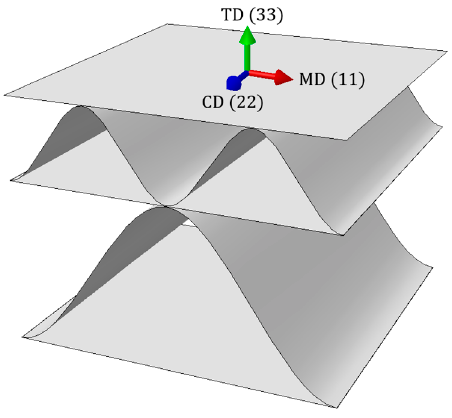
Figure 1. Corrugated cardboard orientation.